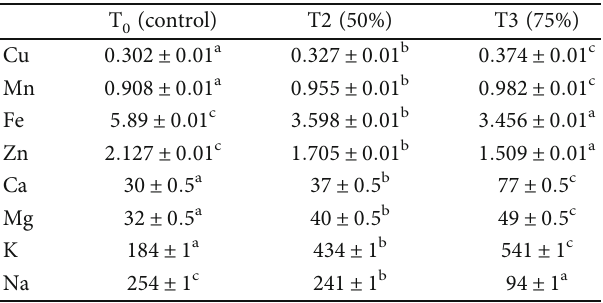
Mean values in the same line with di ff erent superscript letters are signi fi cantly di ff erent ( P < 0 : 05 ). T 0 ð control Þ = 100 % wheat fl our; T1 = 25 % sweet potato and soybean fl ours; T2 = 50 % sweet potato and soybean fl ours; T3 = 75 % sweet potato and soybean fl ours; T4 = 100 % sweet potato and soybean fl